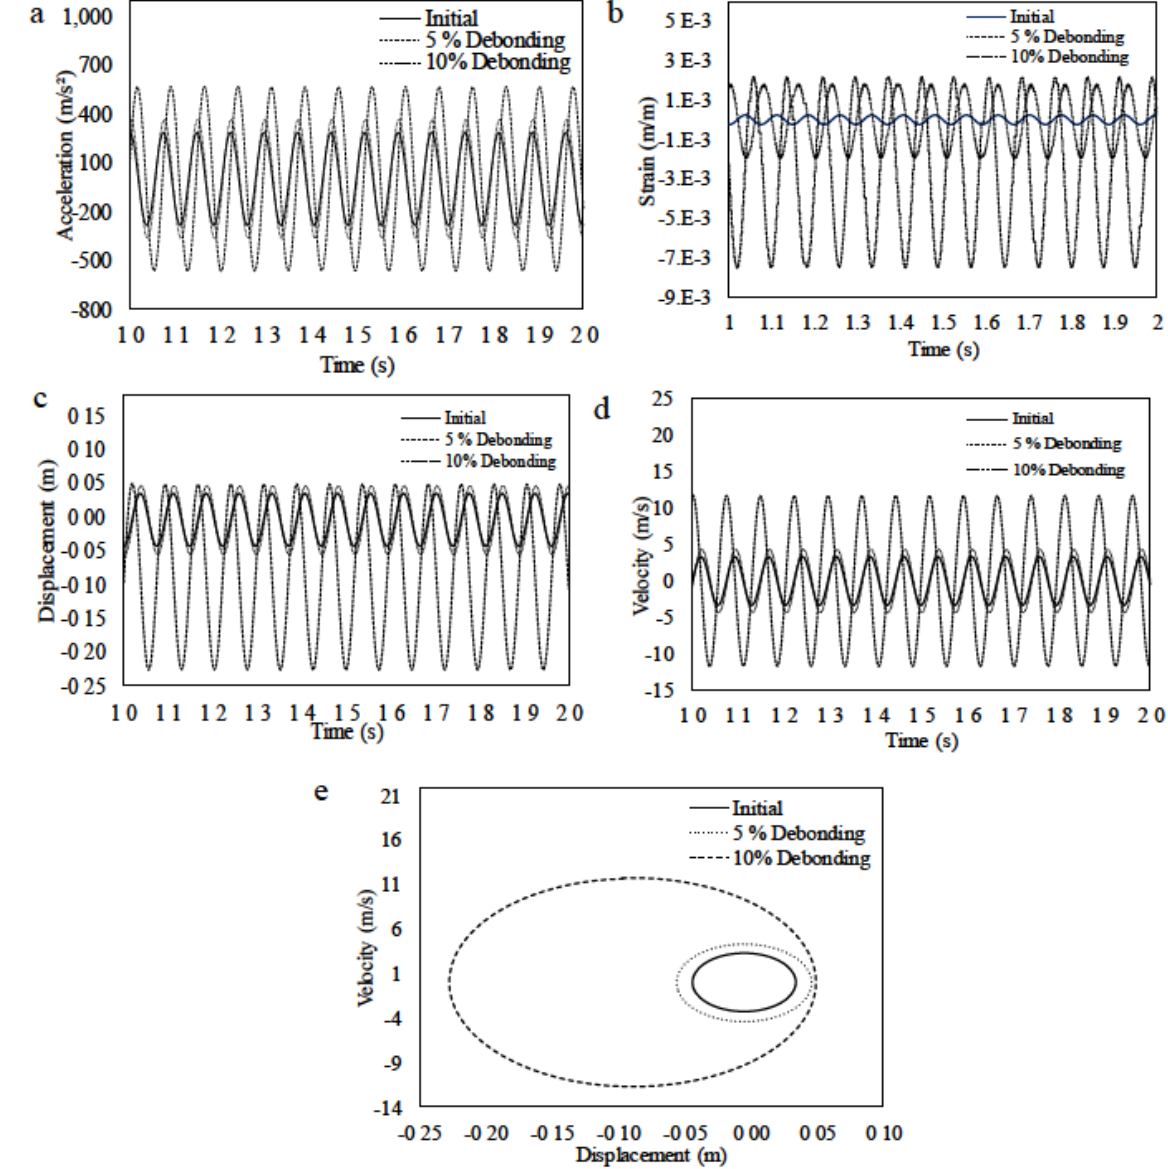
Figure 7: Time history outputs: (a) acceleration, (b) strain, (c) displacement, (d) velocity, (e) phase portrait